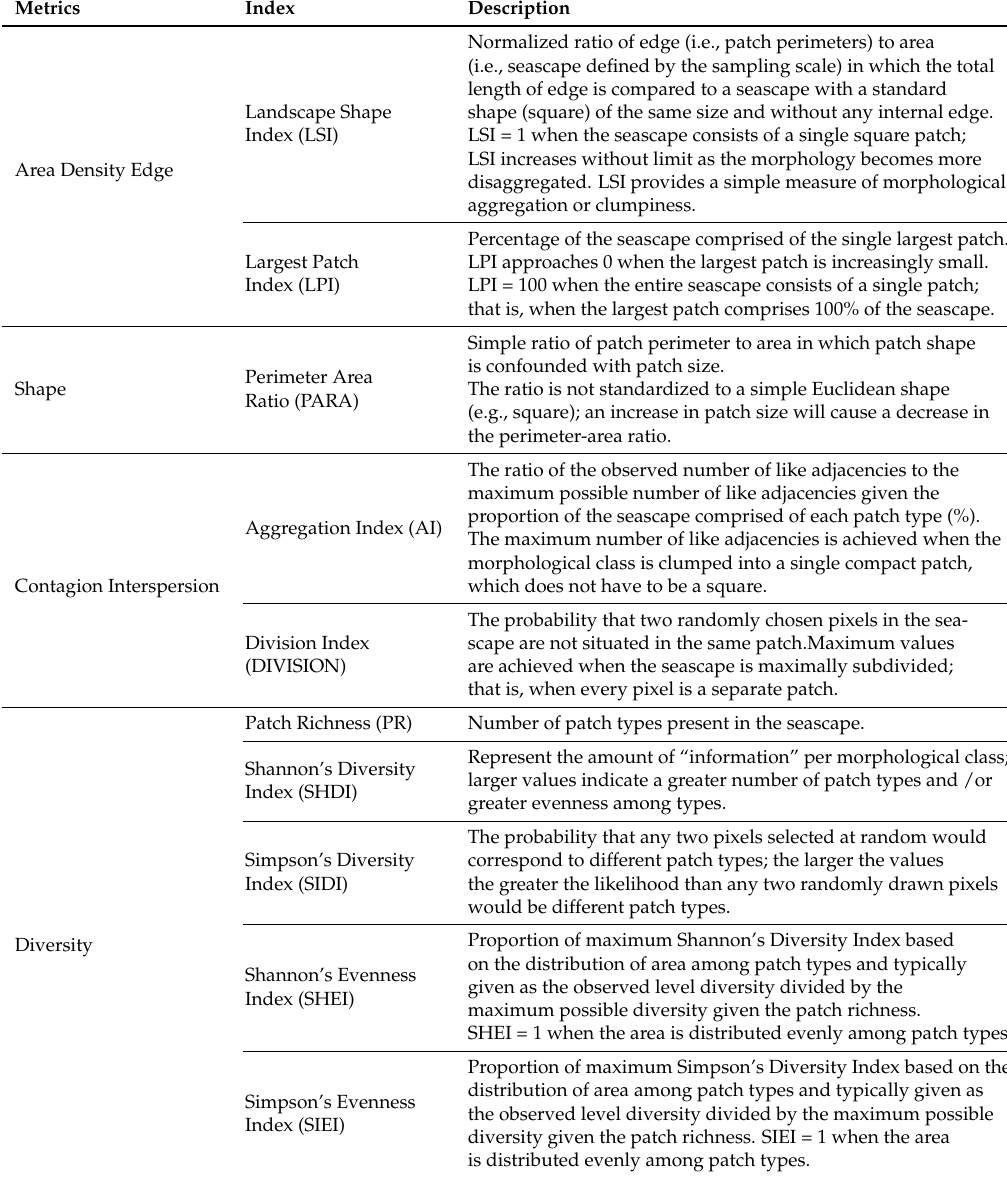
Table 1. Seascape metrics estimated for the case study area of Ponta do Ouro Marine Reserve (Mozambique). The seascape metric descriptions are based on those for landscape analysis obtained from FRAGSTATS v4 [65]. All metrics are dimensionless except for the Largest Patch Index (LPI) (%), AI (%) and DIVISION (ratio). Here, patch refers to each of the digitized individual polygons falling within a given morphological